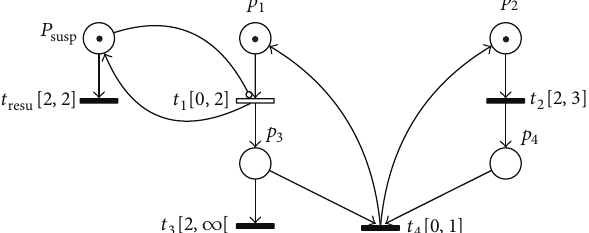
Figure 9: Time Petri net of Figure 1, controlled by inhibitor hyper- arcs ( 𝑇 𝑐 = {𝑡 1 }) .